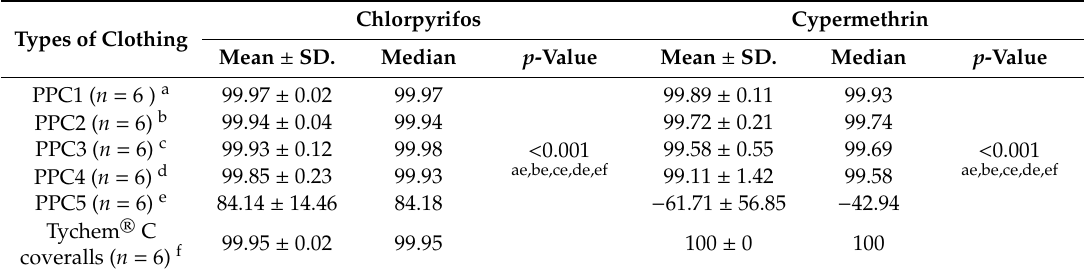
Table 3. Percentage of protection e ffi ciency for chlorpyrifos and